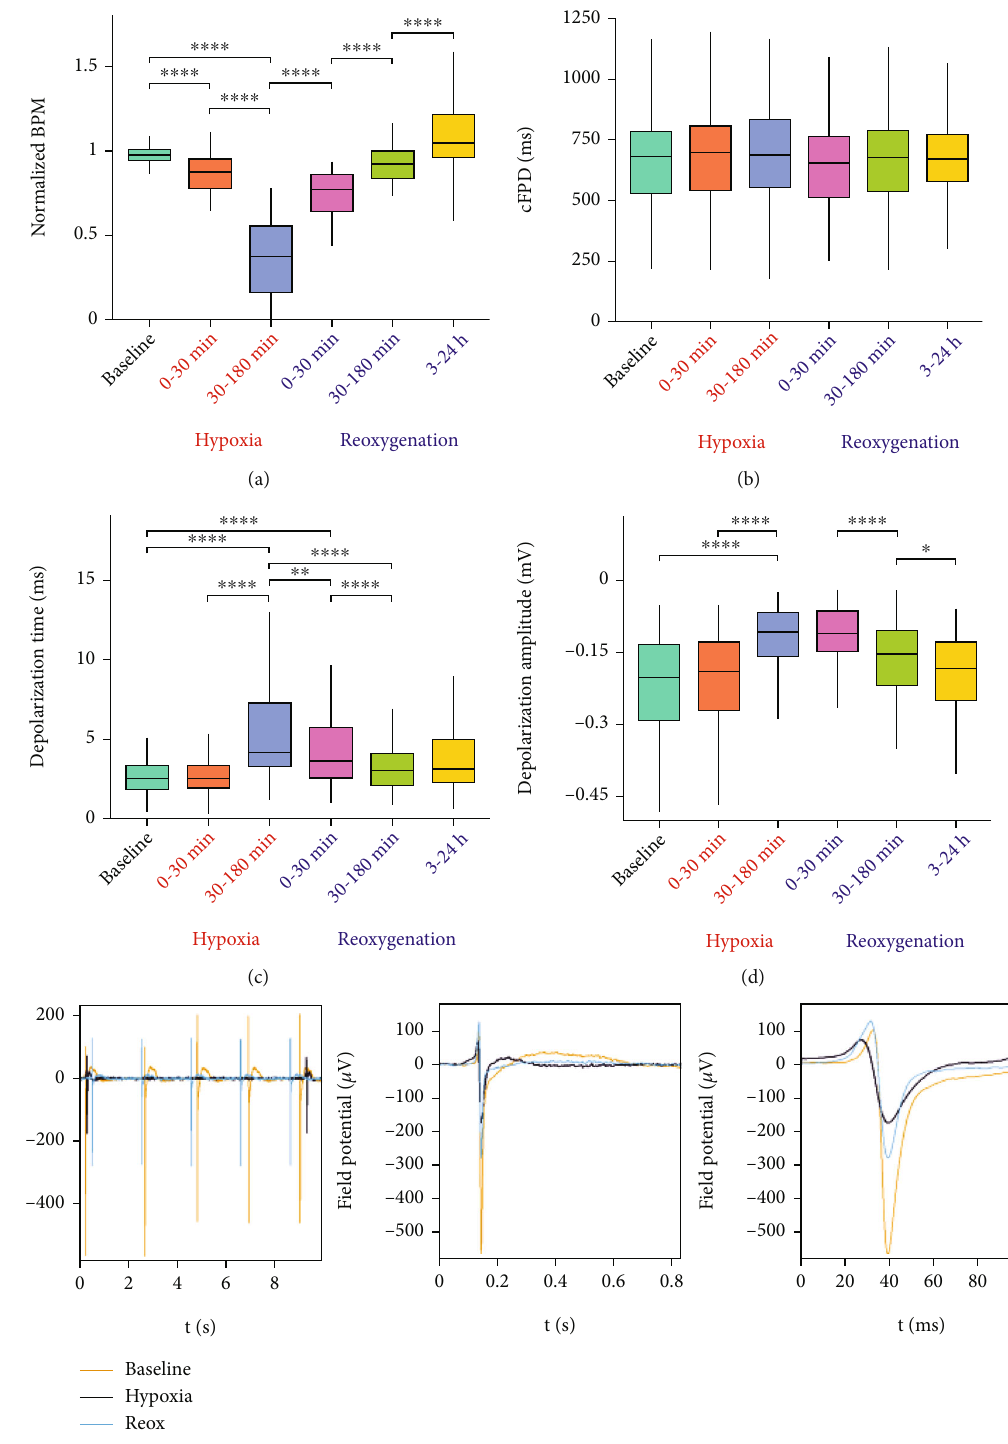
Figure 4: Functionality of the hiPSC-CMs was evaluated via MEA measurements during baseline, hypoxia, and reoxygenation. (a) Normalized beating frequency (beats per minute, BPM) of hiPSC-CMs decreased during hypoxia and was restored during reoxygenation. (b) Corrected fi eld potential duration (cFPD) did not change signi fi cantly during hypoxia or reoxygenation. (c) Depolarization time of the hiPSC-CMs increased during hypoxia and returned close to baseline during reoxygenation. (d) hiPSC-CM depolarization amplitude decreased signi fi cantly during hypoxia and recovered during reoxygenation. (e) Examples of a fi ltered FP signals acquired from MEA recordings during baseline (yellow), hypoxia (black), and reoxygenation (blue). ∗ p < 0 : 05 , ∗∗ p < 0 : 01 , ∗∗∗ p < 0 : 001 , and ∗∗∗∗ p < 0 : 0001